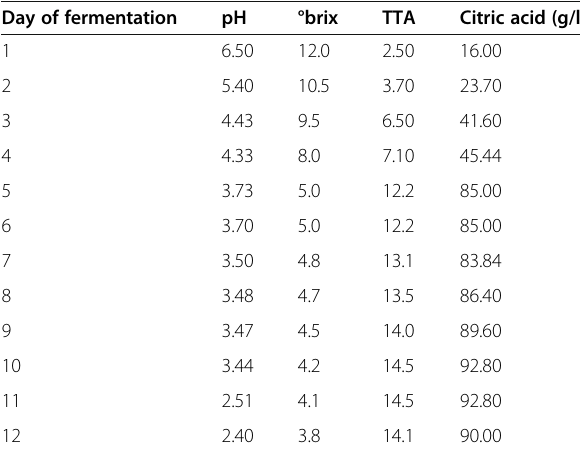
Table 1 Quantitative determination of citric acid produced by A . niger LCFS 5 in the cashew apple juice